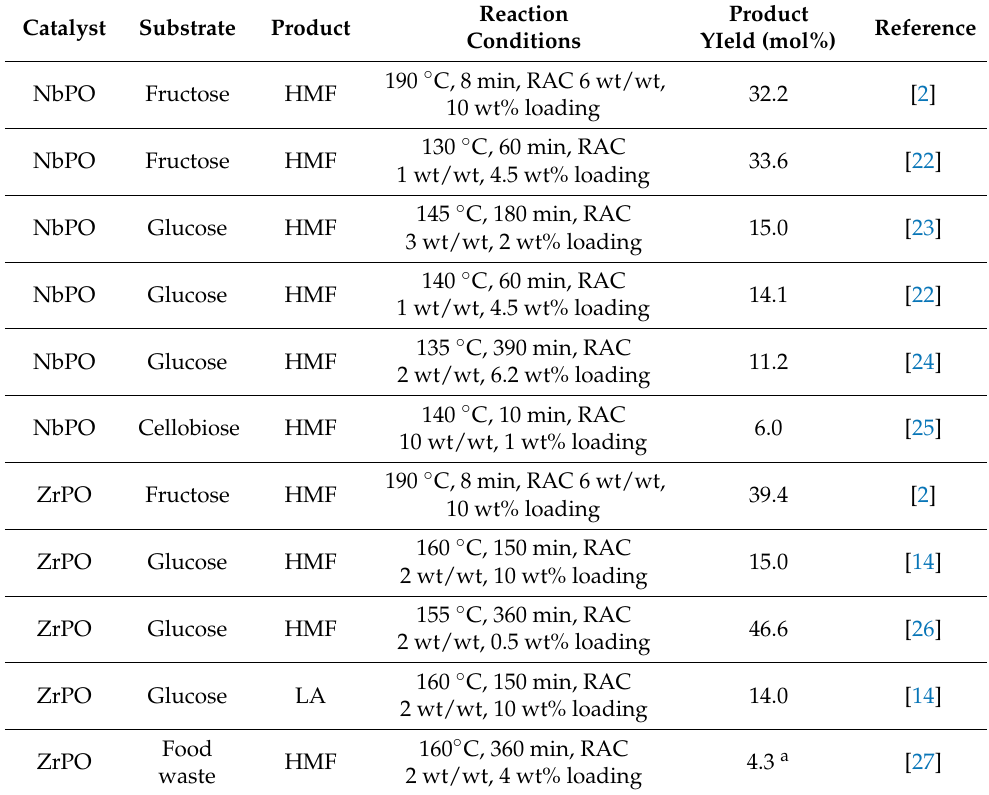
Table 1. Literature review on HMF and LA production in water catalyzed by NbPO and ZrPO (RAC = substrate/catalyst ratio